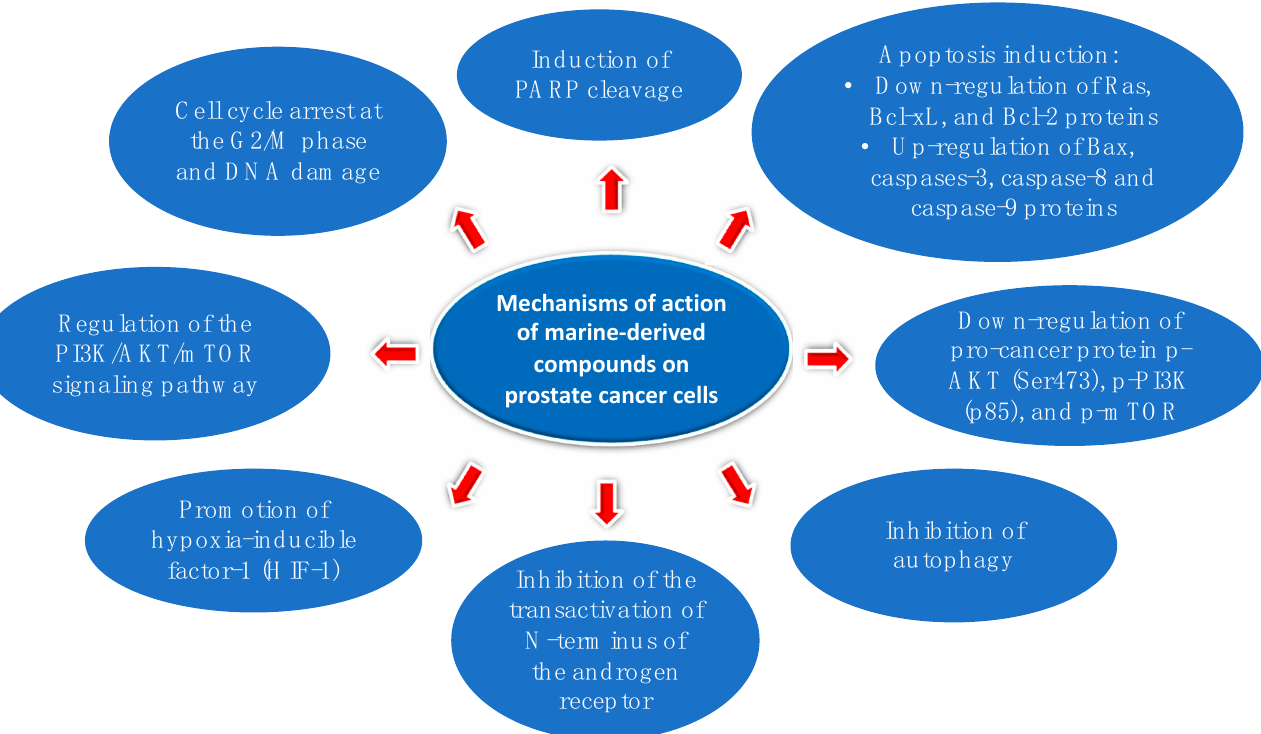
Figure 6. Most common mechanisms of action induced by marine-derived compounds on prostate cancer cells. PARP stands for poly ADP-ribose polimerase, PI3K for phosphatydilinositol 3-kinase, p-PI3K for phospho phosphatydilinositol 3-kinase, AKT for protein kinase B, mTOR for mammalian target of rapamycin, p-mTOR for phospho-mammalian target of rapamycin.